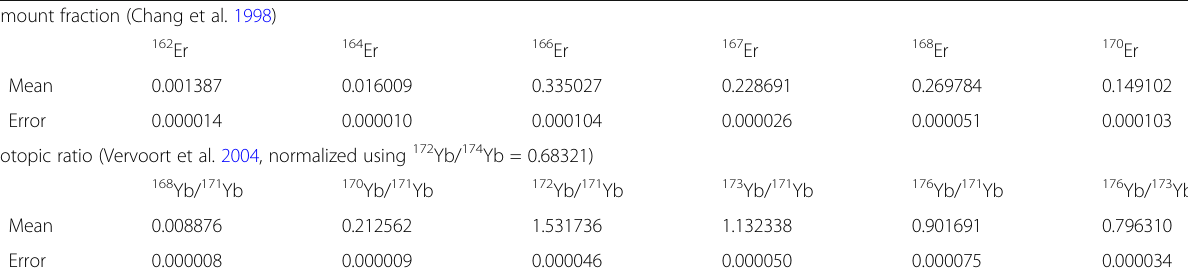
Isotopic ratio (Vervoort et al. 2004, normalized using 172 Yb/ 174 Yb = 0.68321) 168 Yb/ 171